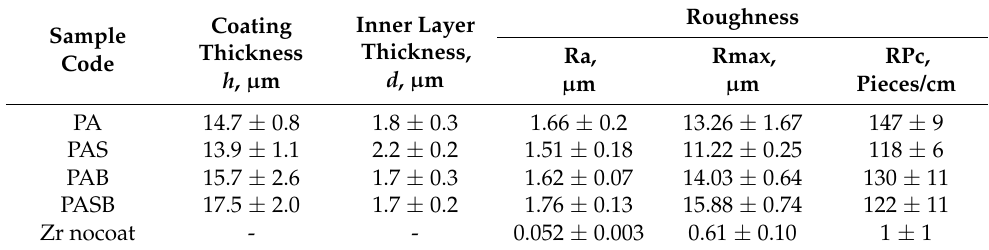
Table 3. Morphological characteristics of the PEO coatings.